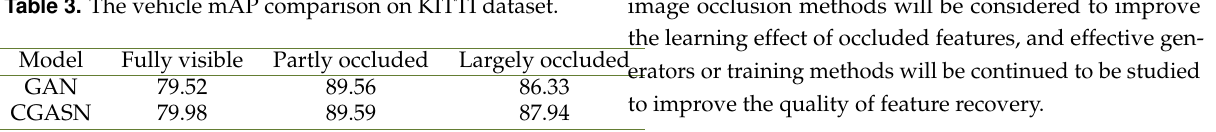
Table 3. The vehicle mAP comparison on KITTI dataset.